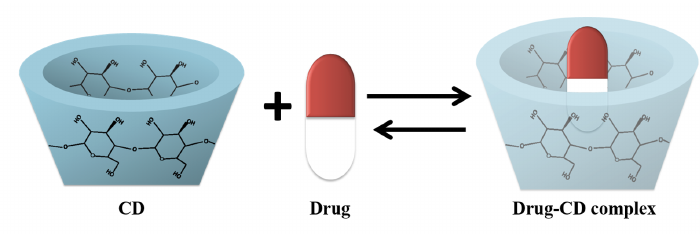
Figure 2. Dynamic equilibrium for drug-cyclodextrin complex.